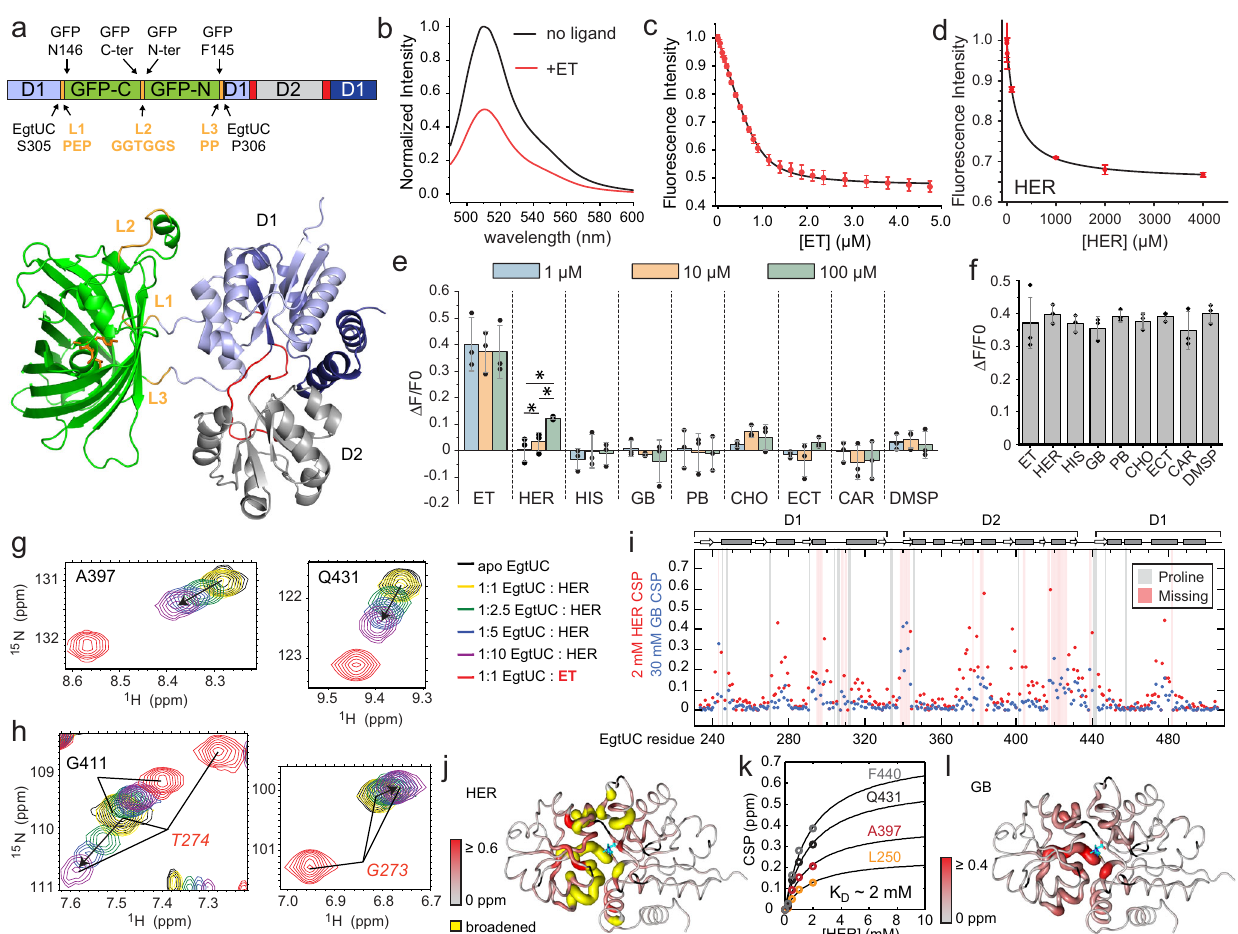
Fig. 5 | The Sp EgtUC binds ET with high selectivity. a Upper , schematic repre- triplicate measurements with each data point represented by a fi lled circle. * p <0.05 in a one-sided t-test. f Same as e , except that 1 µ M ET (left bar) was com- sentation of the EgtUC-GFP fusion protein construct; lower , ribbon representation paredto amixtureof1 µ METand 100 µ Mof theindicated ligand (otherbars).Each of an AlphaFold2 model of the EgtUC-GFP fusion, with domains indicated. b GFP µ MET. c ETbinding fl uorescenceemissionspectra, λ bar represents triplicate measurements ( fi lled circles). g and h Movement of the ex =470nmwithorwithout10 indicated backbone NH crosspeak from the apo-state (black) as L -hercynine (HER) totheEgtUC-GFPfusionprotein,monitoredbyquenchingoftheGFP fl uorescence. is added (yellow to purple), compared to the cross peak position of ET-bound Eachdatapointisshownasthemeanand standarddeviationofthreeindependent EgtUC(red). i Backbone chemicalshift perturbation(CSP)mapsresulting fromthe replicates. Continuous curve, fi t to a 1:1 binding model; see Table 1 for binding addition of 2mM HER or 30mM glycine-betaine (GB). j Backbone CSP maps upon parameters. d sameas c except L -hercyninewasaddedtoEgtUC-GFPfusionprotein HER binding painted onto the Sp EgtUC structure. k Global fi ts ofthe movement of (Table 1). e Quenching of GFP fl uorescence of the EgtUC-GFP fusion protein fol- selected NH cross-peaks as a function of [HER] to a 1:1 binding model are shown lowing addition of 1, 10, or 100 µ M of the indicated ligand (see Supplementary (Table 1). l Backbone CSPs upon HER binding painted onto the Sp EgtUC structure. Fig.14aforchemicalstructures).HIS, L -histidine;PB,proline-betaine;CHO,choline; Source data for c – f , i , and k are provided as a Source Data fi ECT, ectoine; CAR, carnitine; DMSP, dimethylpropiothetin. Each bar represents